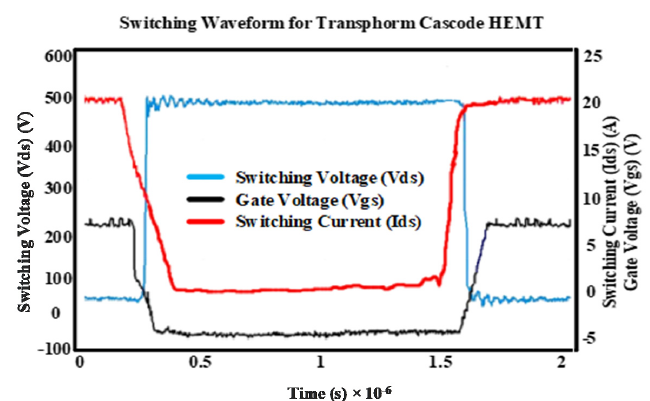
Figure 15. Switching waveforms for the Transphorm GaN HEMT cascode.